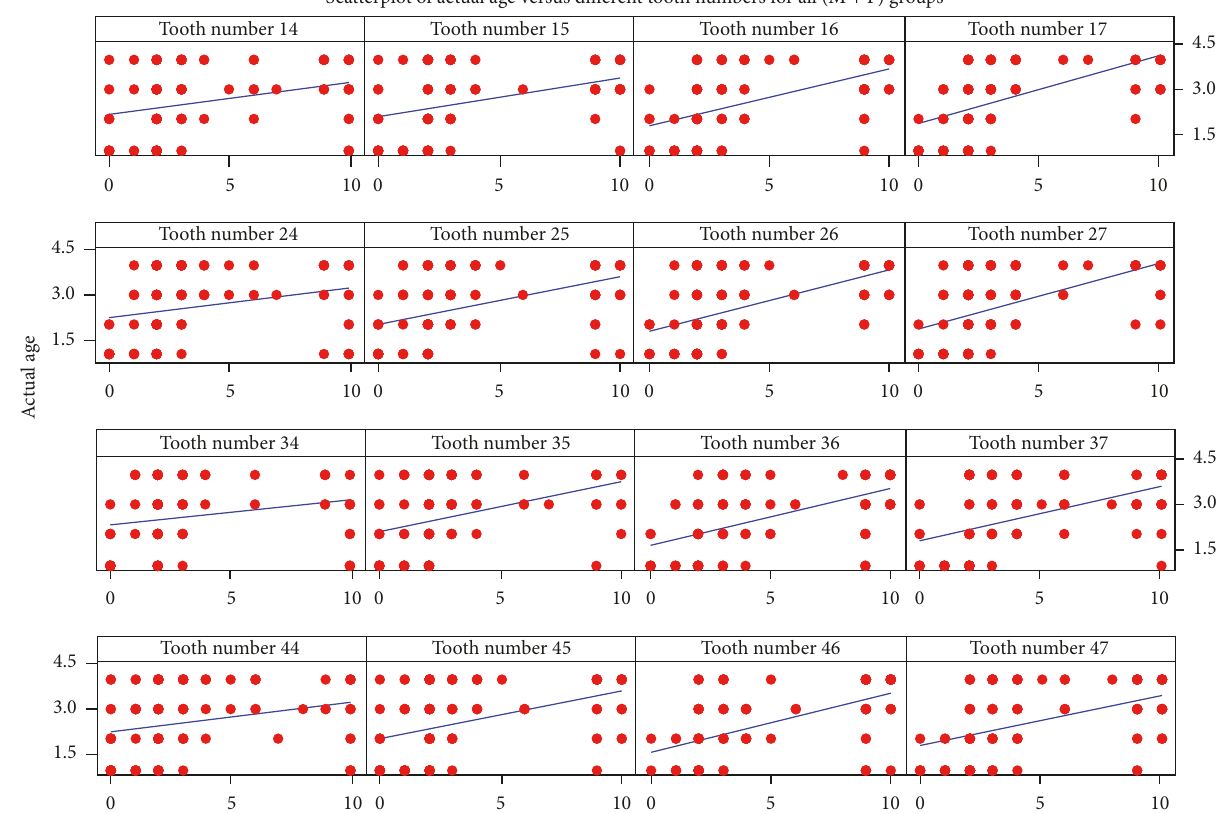
Figure 1: Scatter plot showing correlation of actual age with occlusal wear